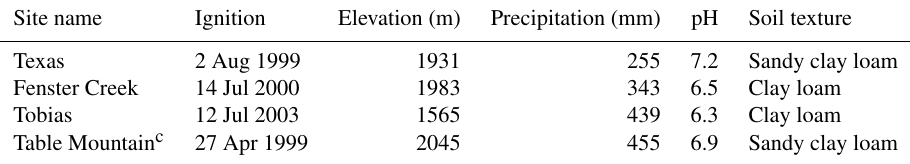
Table 1. Characteristics of sites sampled in Idaho, USA, in 2015. Includes fire ignition dates a and characteristics averaged across all plots, burned and unburned, at each site, including elevation, mean annual precipitation (30-year average from 1981 to 2010 b ), soil pH, and most common soil texture.